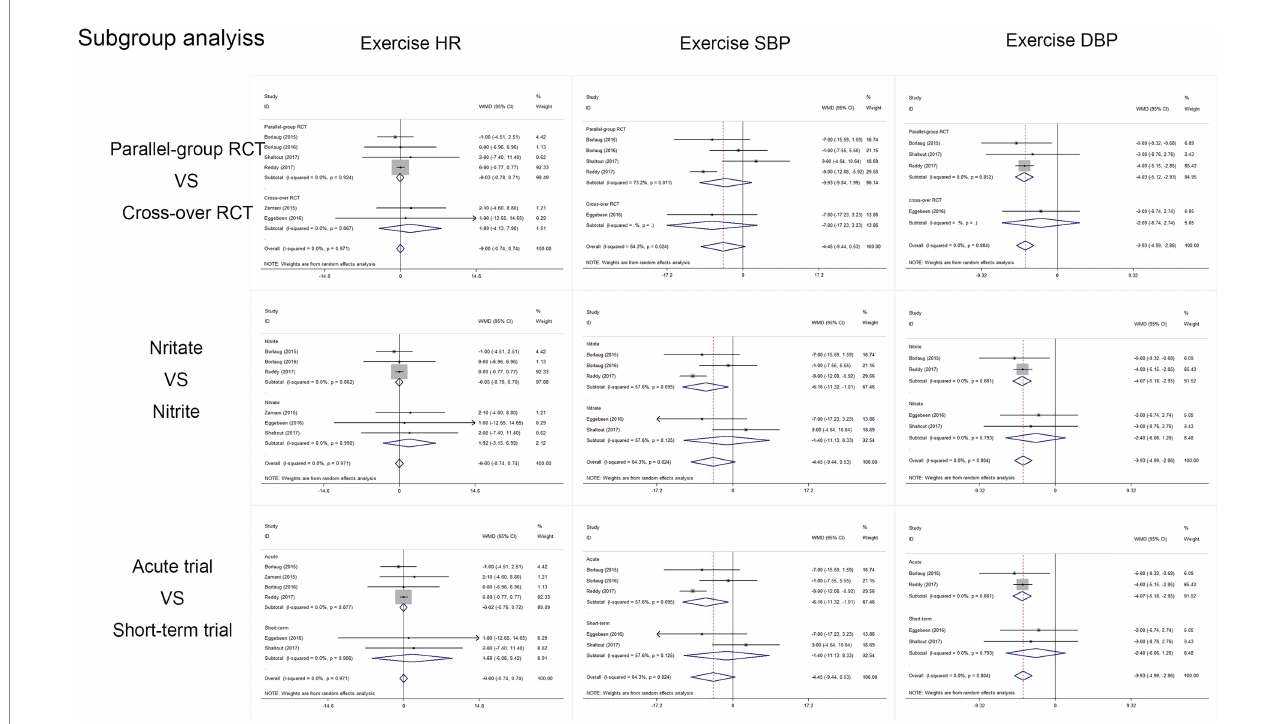
FIGURE 5 Subgroup analyses of secondary